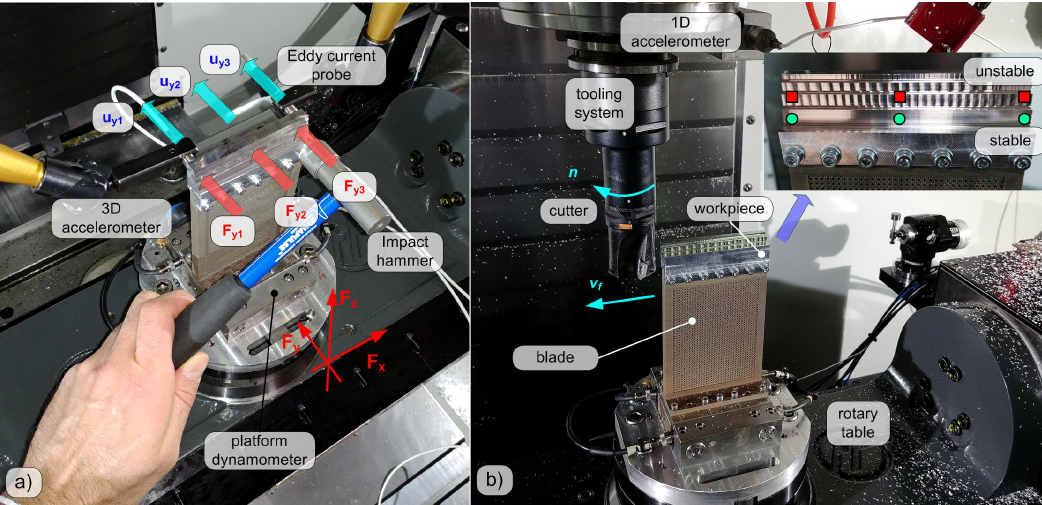
Figure 10. Experimental setup used for modal analysis ( a ) and chatter tests ( b